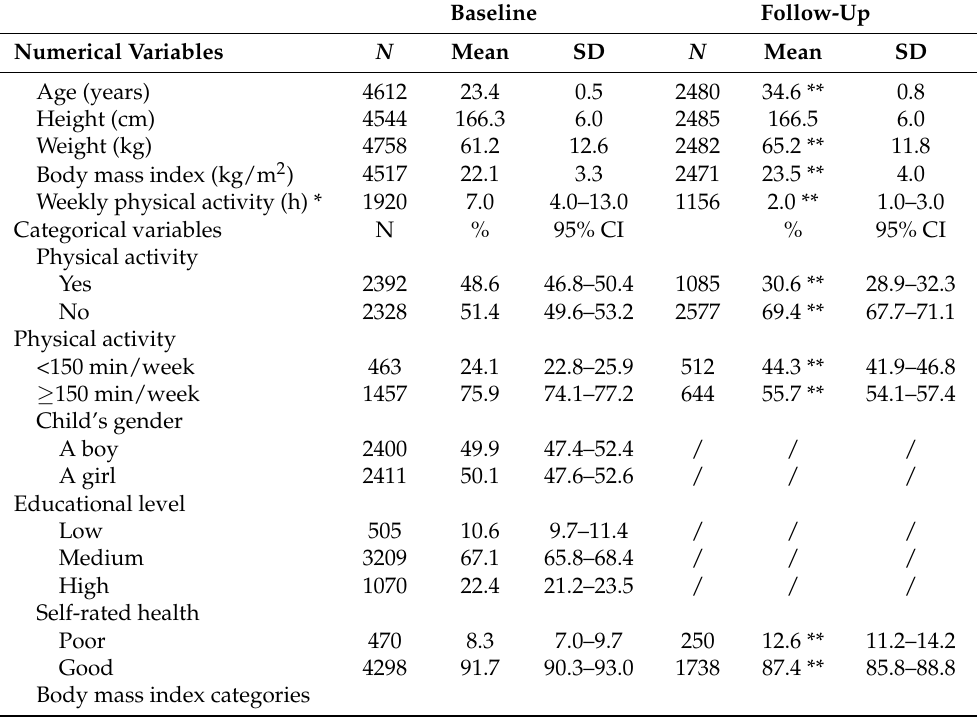
Table 1. Descriptive statistics of the study participants at baseline and